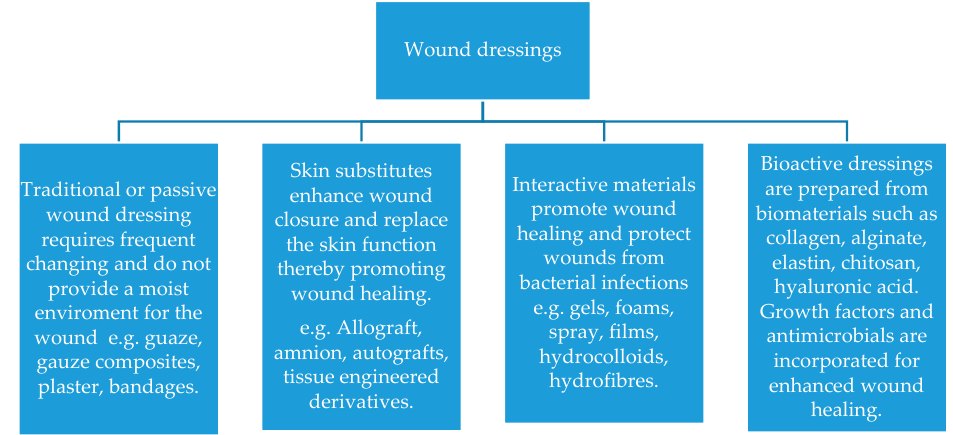
Figure 2. Classification of wound dressings.